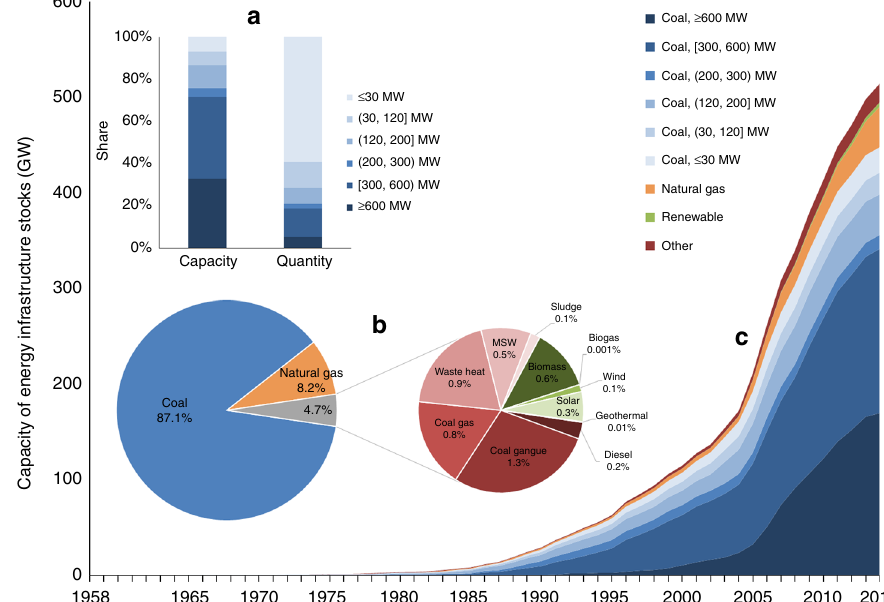
Fig. 1 In-use stocks of energy infrastructure in the 1604 Chinese industrial parks. a The inner bar chart refers to the organization of stocks in terms of the rated capacity and number of units. b The pie chart refers to the fuel structure of stocks. c The stack curve refers to the cumulative capacity of the stocks, which was calculated as the stock in last year + the added capacity in this year — the retired capacity in this year. Source data are provided as a Source Data fi